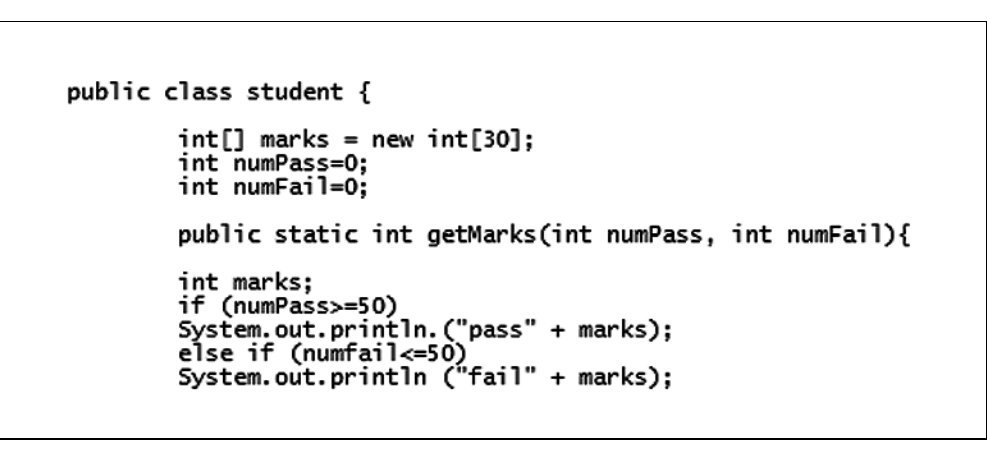
Figure 3 Solution submitted by one of the